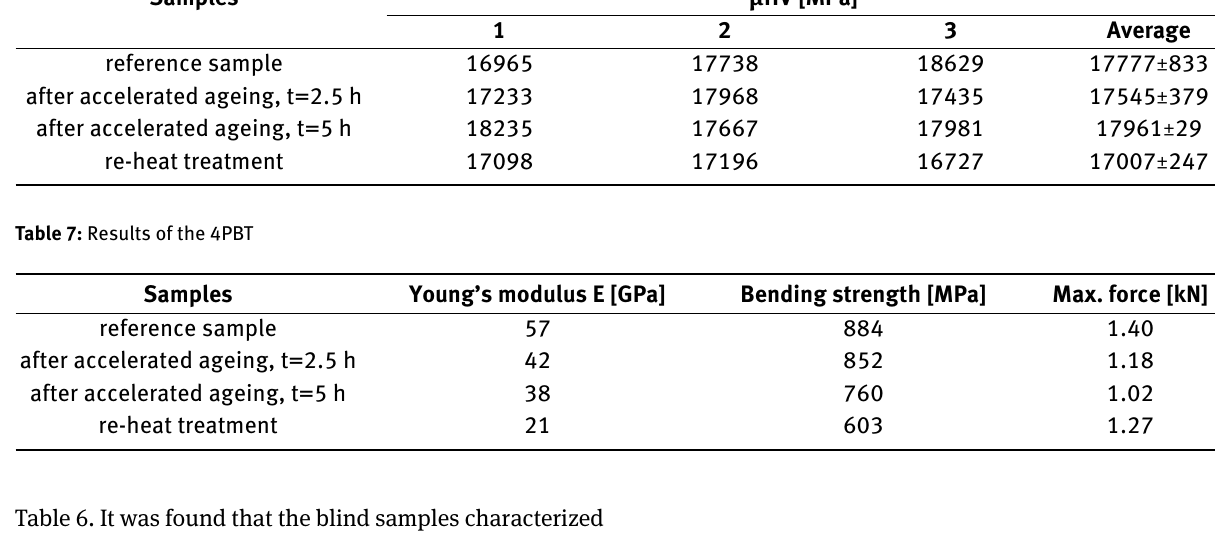
Table 6. It was found that the blind samples characterized the best bending